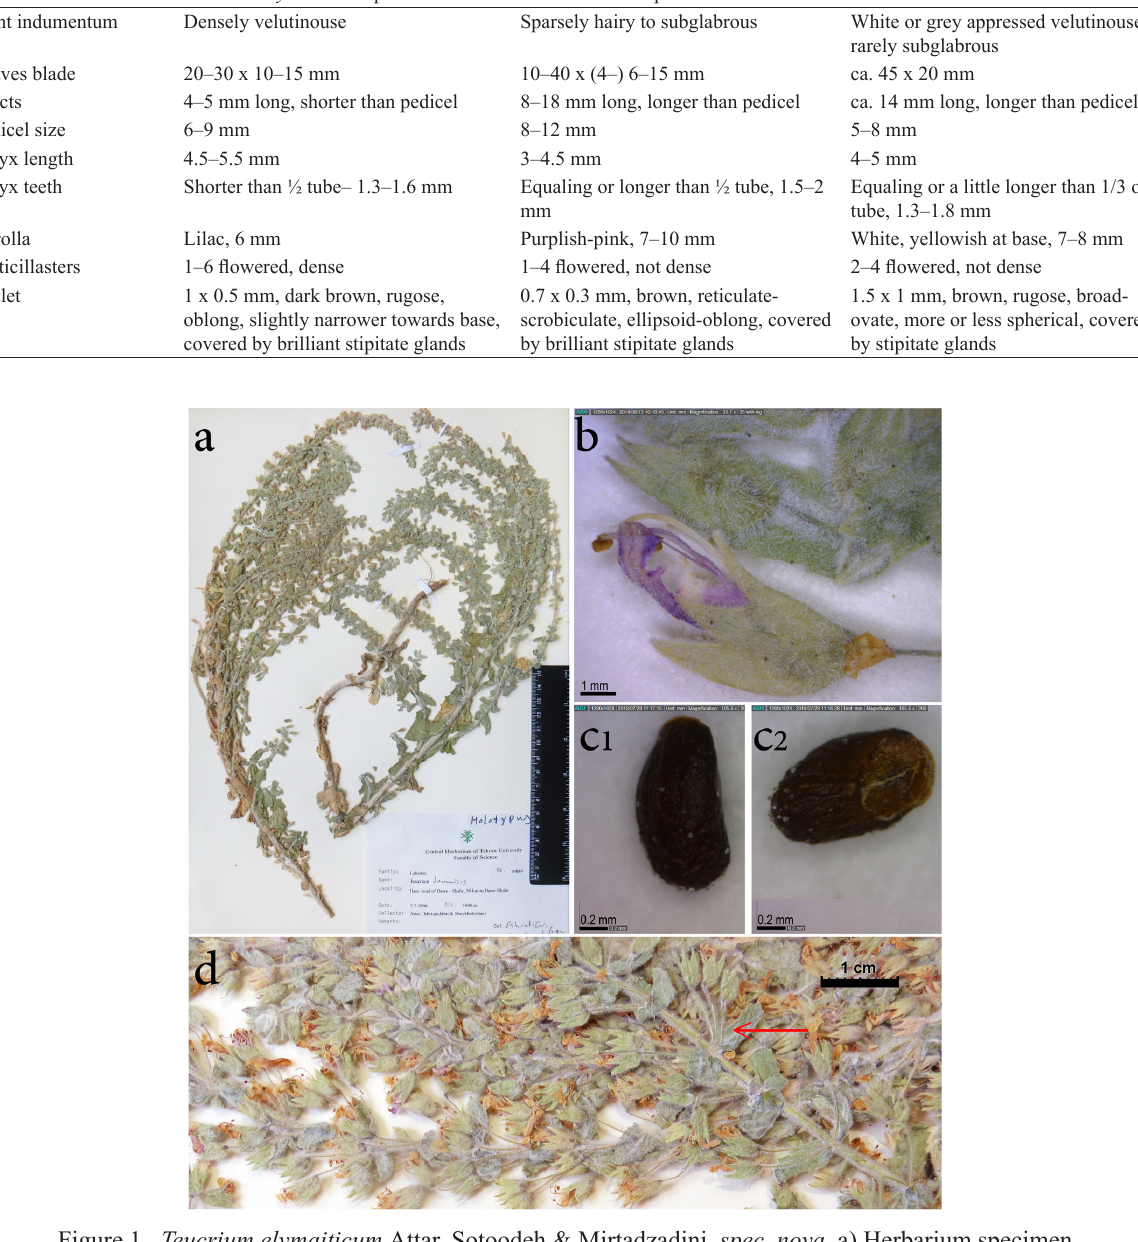
Figure 1. Teucrium elymaiticum Attar, Sotoodeh & Mirtadzadini, spec. nova. a) Herbarium specimen (holotype: TUH), b) Flower at anthesis, c) Nutlet (c1 – view from above, and c2 – view from the bottom), d) Bracts and verticillasters (pointing with